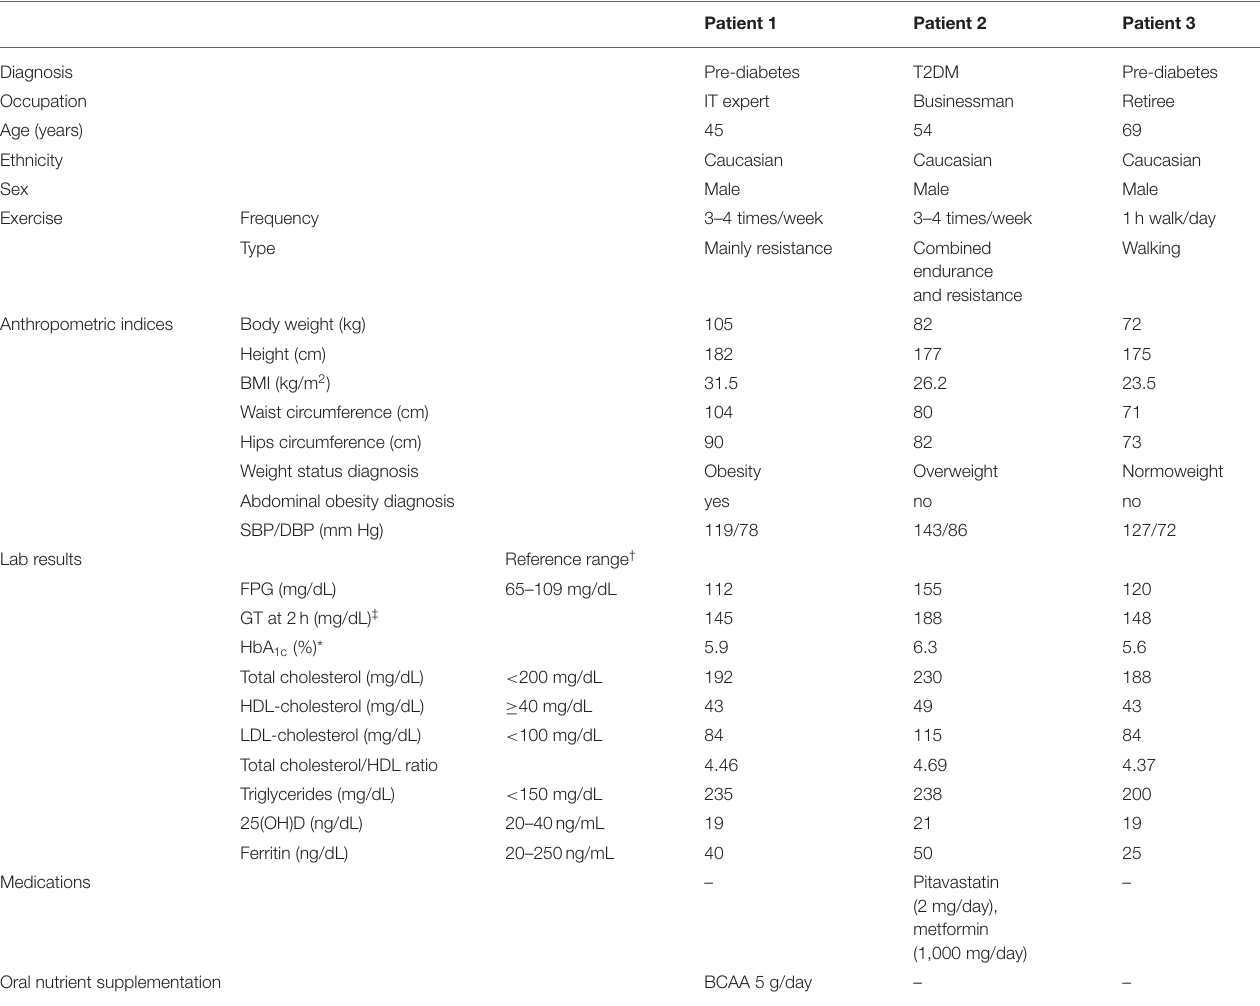
TABLE 1 | Patient characteristics at